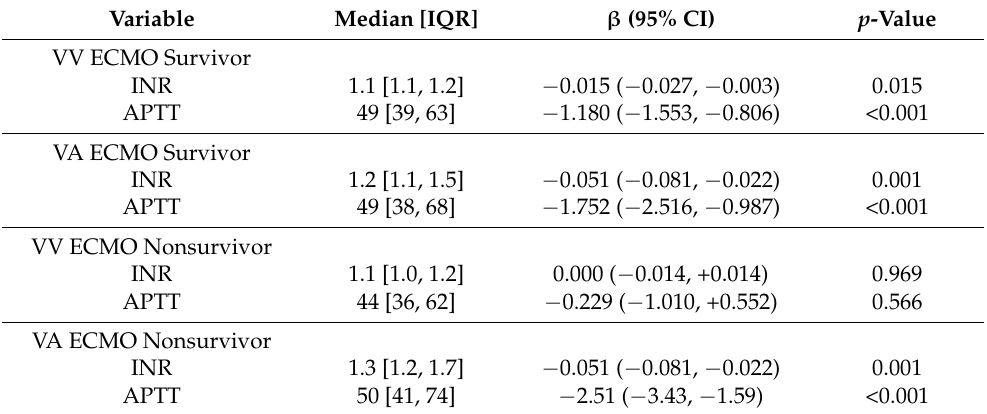
Table 4. Correlation of INR and APTT in VA and VV ECMO survivors and nonsurvivors over 28